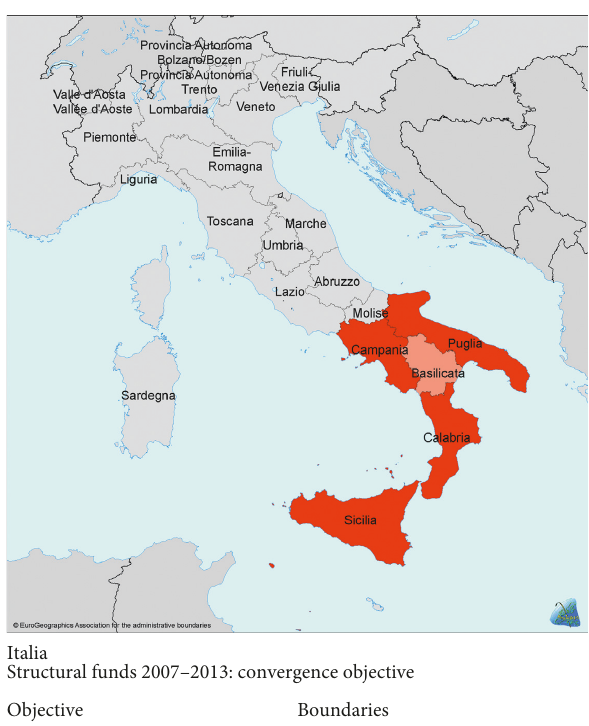
Figure 1: POI Energia 2007–2013—convergence regions in